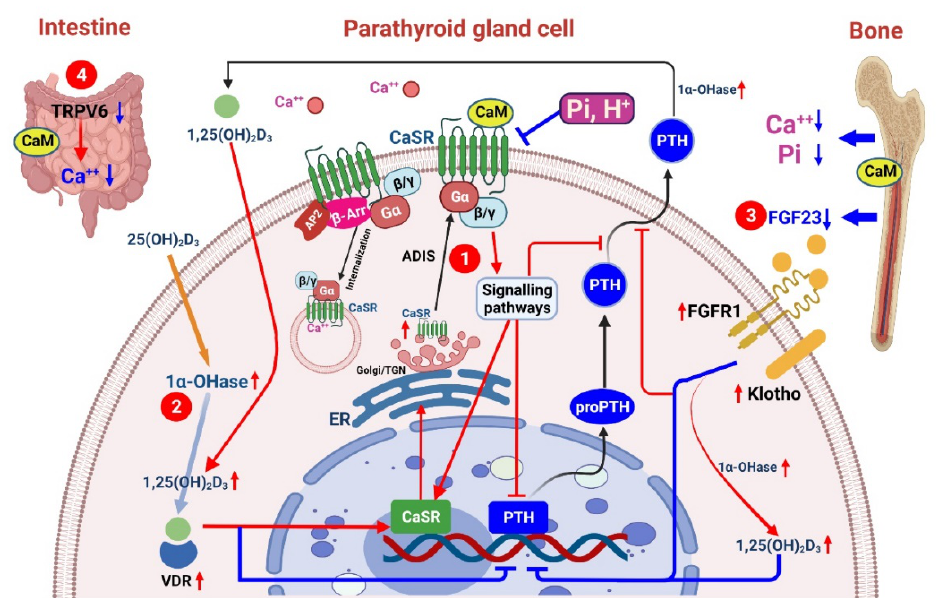
Figure 1. Effects of calcimimetics (CaMs) on parathyroid hormone (PTH) synthesis and secretion in chronic kidney disease (CKD). CaM compounds prevent increases in serum PTH concentrations and parathyroid hyperplasia in CKD and severe secondary hyperparathyroidism (SHPT). These changes occur despite decreases in serum 1,25-dihydroxy vitamin D3 (1,25(OH)2D3) and increases in serum phosphate, suggesting that calcium receptors play a prominent role in regulating parathyroid cell proliferation [60] .